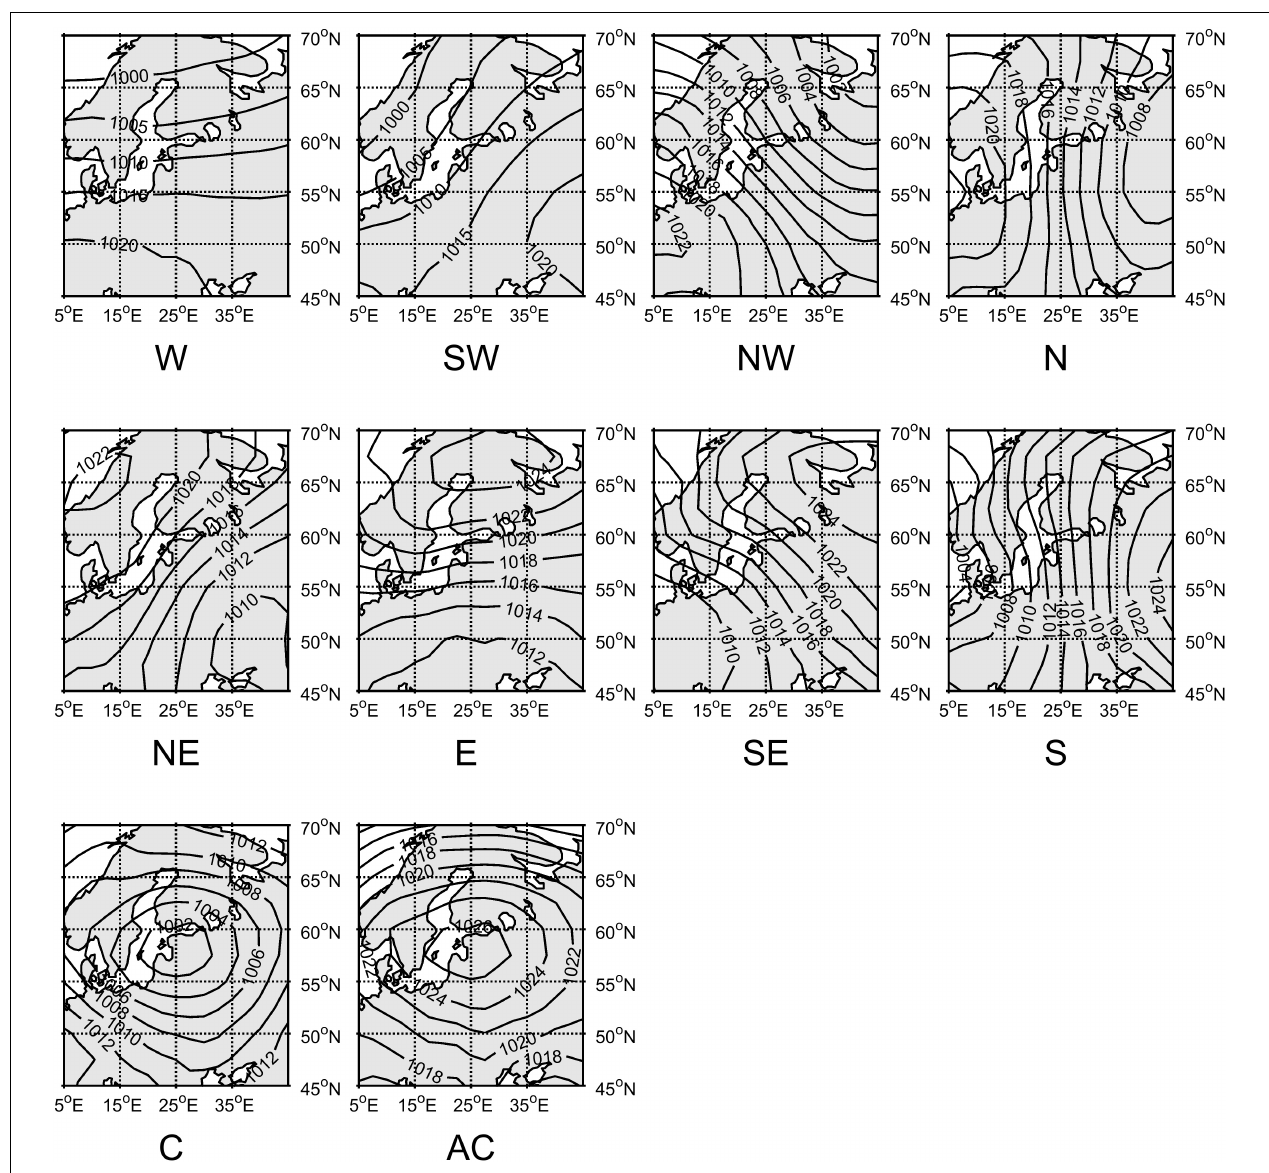
FIGURE 2 | Mean sea level pressure values for GWT10 weather types estimated from daily values for 1948–2015. Directional types W, SW, NW, N, NE, E, SE, S, and C – cyclonic and AC – anticyclonic type.